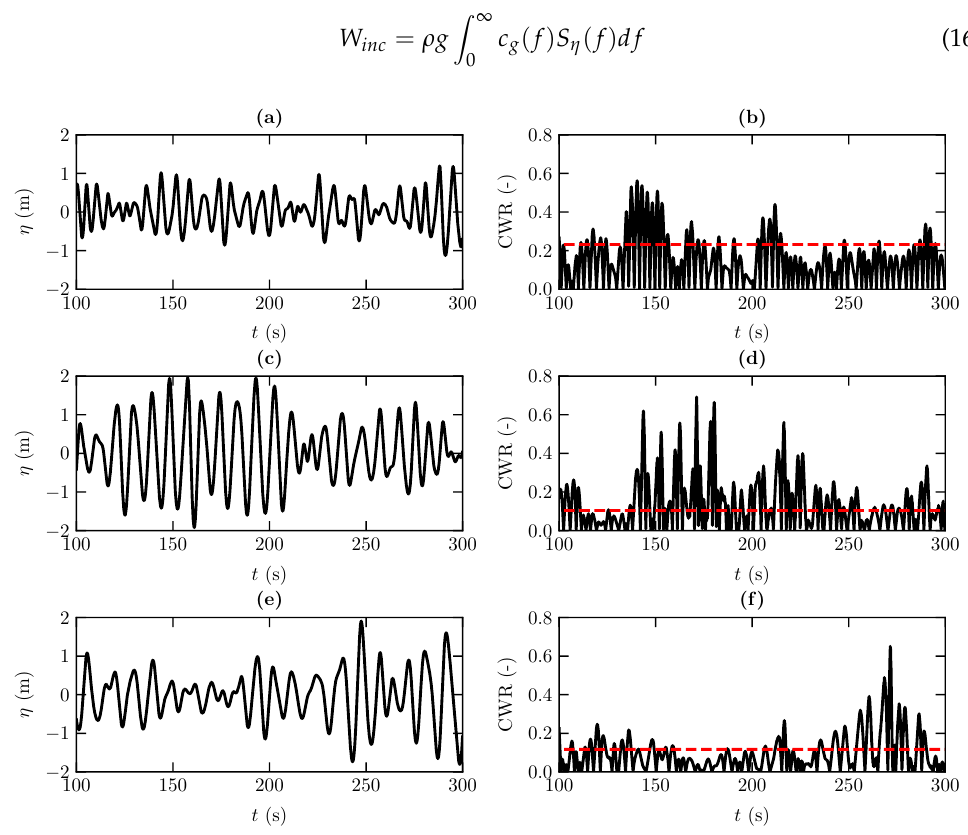
Figure 12. Detail of surface elevation and CWR for ( a , b ) H s = 2.5 m and T p = 7 s, ( c , d ) H s = 2.5 m and T p = 9 s, ( e , f ) H s = 2.5 m and T p = 11 s. In the power capture curve, the horizontal dashed red line indicates the mean power